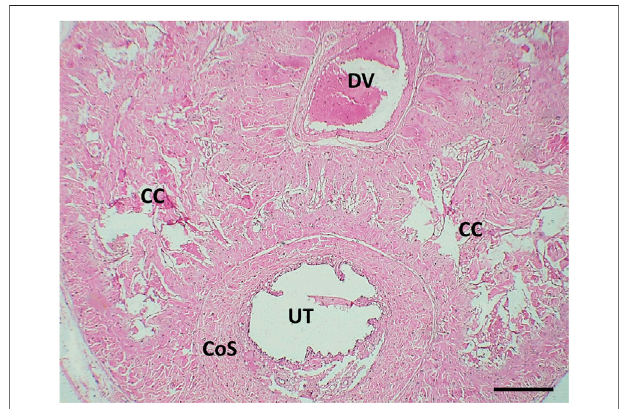
FIGURE 4 | Histological transverse section of the penis of the control rat showing the 2 corpora cavernosa (CC) located dorsal to the corpus spongiosum (CS). UT: urethra. DV: deep dorsal vein of the penis. H&E X40. Scale bar: 500 μ m.